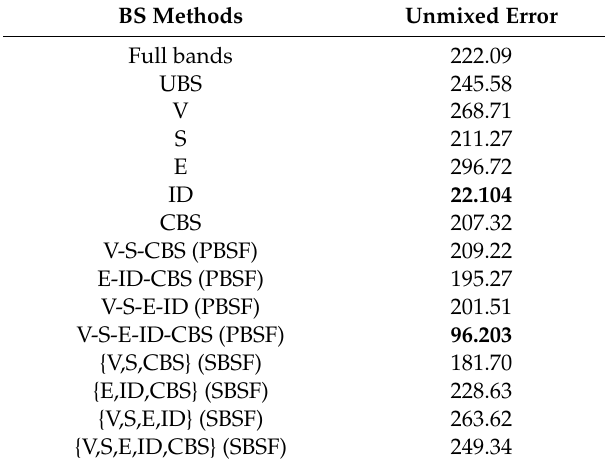
Table 5. Total fully constrained least squares (FCLS)-unmixed errors produced by using 18 target pixels in Table 4 and full bands, uniform band selection (UBS), Variance (V), signal-to-noise ratio (S), entropy (E), information divergence (ID), constrained band selection (CBS), and SBSF and PBSF fusion methods using bands selected in Tables 2 and 3.